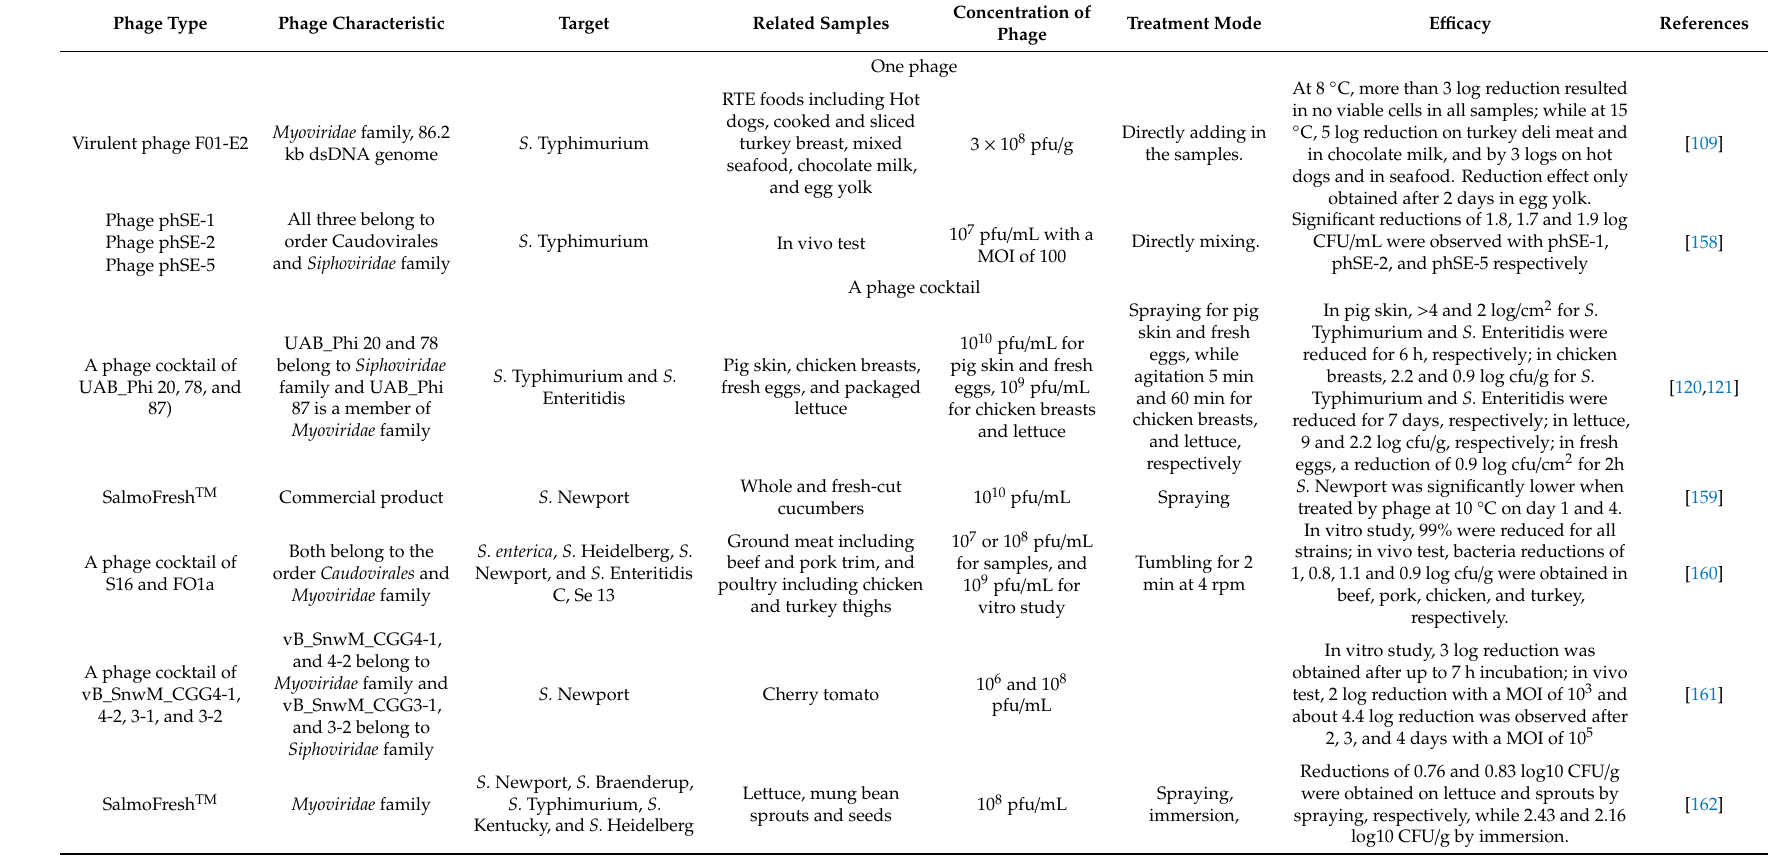
Table A2. Applications of bacteriophage or bacteriophage-based treatments for biocontrol of